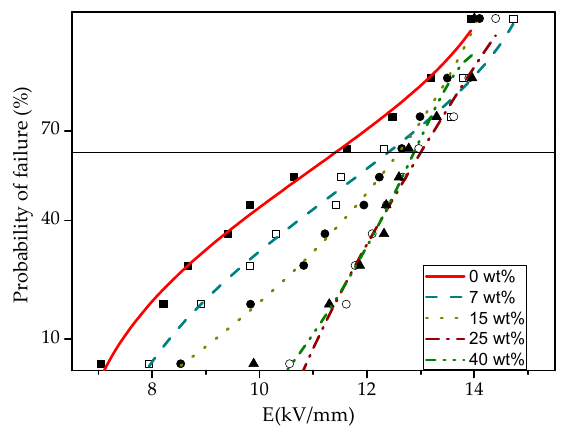
Figure 10. Weibull plot of the breakdown strength of the epoxy nanocomposites with different weight fractions of SrTiO 3 particles.